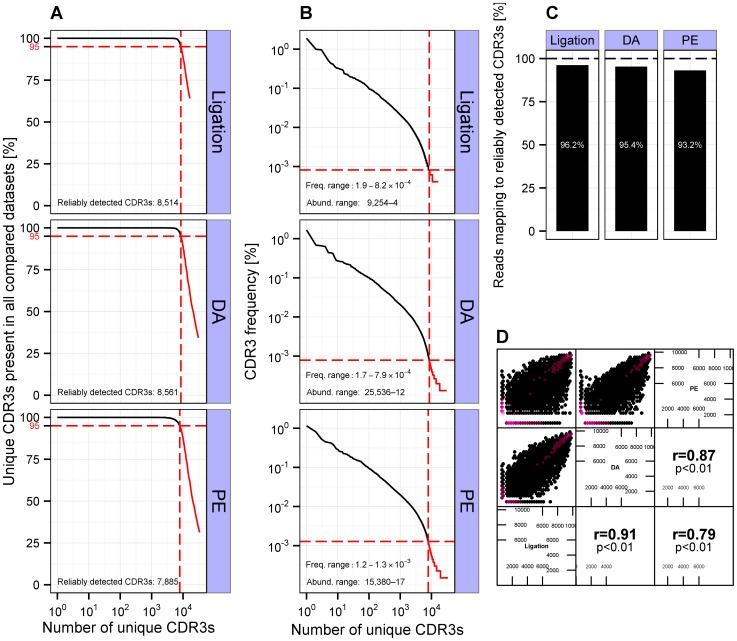
Ligation-, DA-, and PE-based adapter addition methods yield highly comparable HTS datasets.(A) Reliably detected CDR3s were determined as described in Fig. 2 using a 95% CDR3 reliable detection cut-off. On average, ≈8,300 CDR3s were reliably detected with the three different methods. The red dashed line marks the 95% detection cut-off separating reliably detected clones (black line) from non-reliably detected ones (red line). (B) Average frequency and abundance ranges (≈1.6–5.8×10−4% and ≈17,000–11 reads per unique CDR3, respectively) of reliably detected CDR3s. (C) Reliably detected CDR3s corresponded to an average of ≈95% of total sequencing reads for the three different methods. (D) For each method, ranks of reliably detected CDR3s were determined and displayed by assigning the highest rank to the CDR3 with the highest abundance; analogous to the hypothetical dataset presented in Fig. 2 the highest frequency CDR3 would be assigned the rank 10, the second highest CDR3 the rank 9 and so forth. Pairwise Spearman’s rank correlation coefficients for Ligation, DA, and PE were high (r≥0.79). To circumvent overplotting, correlation plots are displayed using hexagons–purple indicates where data points accumulate.